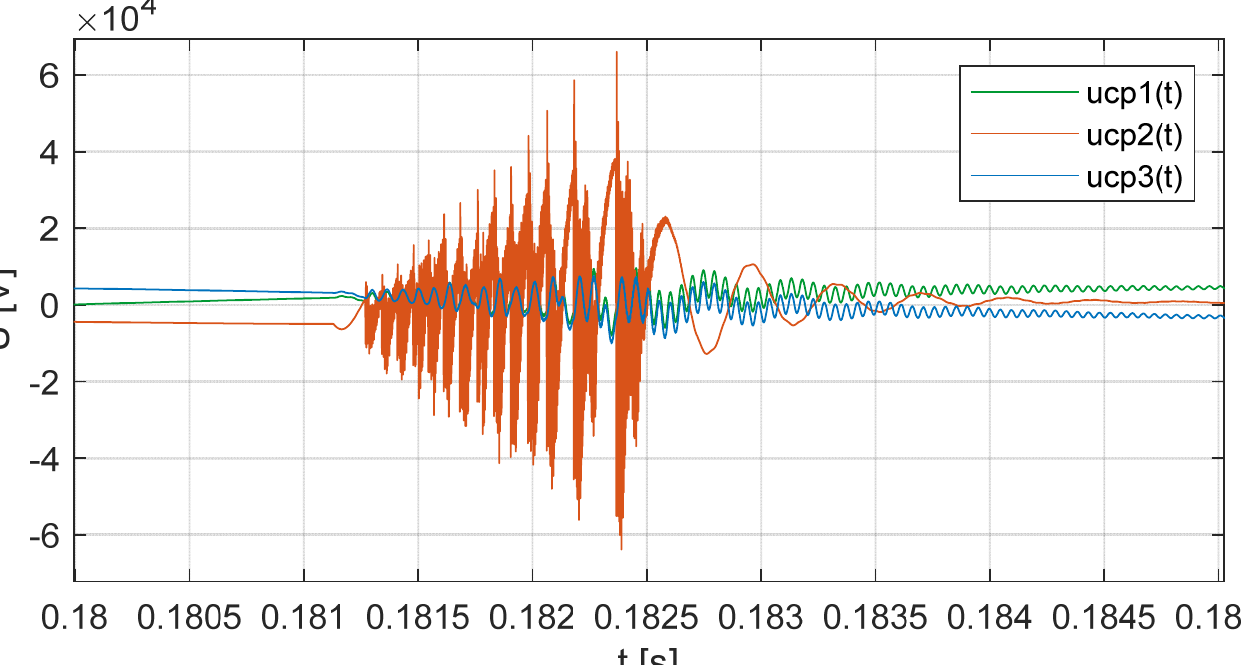
Figure 15. Simulation results—Load voltage 𝑢